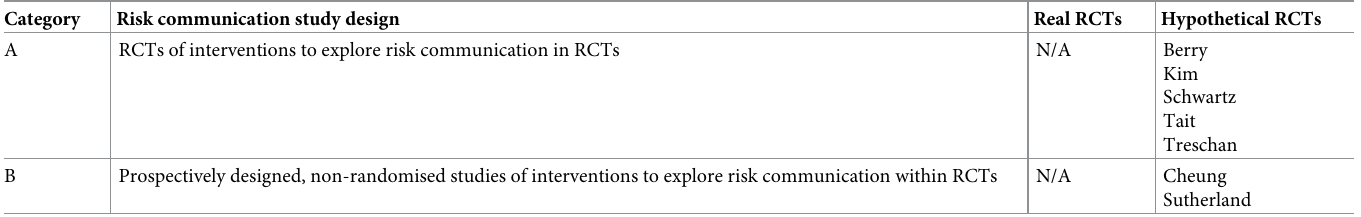
Table 2. Catalogue of included studies by study design and real or hypothetical RCT